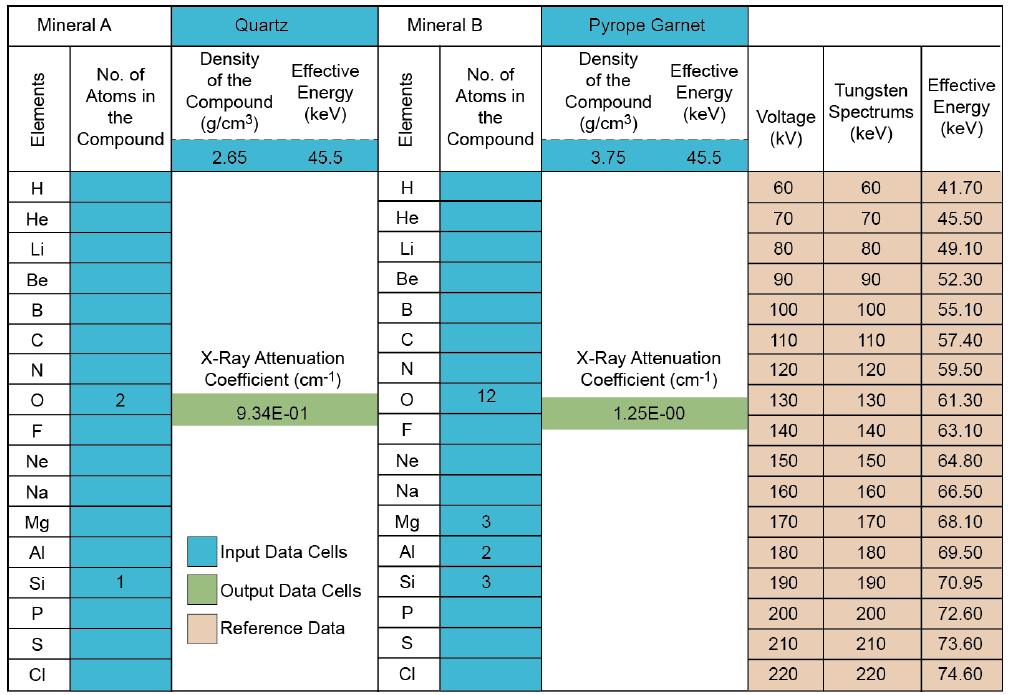
Figure 4. Illustration of the MXLAC user interface for calculation of mineral linear attenuation coefficients, with inputs under number of atoms in the compound, density and voltage for each mineral indicated in blue. The calculated output is show in green. Table 1. Scanning parameters to optimize discrimination between minerals.